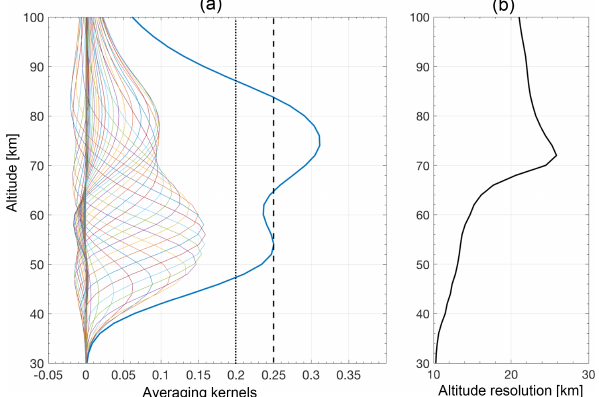
Figure 5. The estimated error contributions to the CORAM CO pro- files. The spectrum noise is calculated as an average of the noise on all CORAM measurements, and the other estimates are calculated through perturbations about the a priori CO profile (Sect.